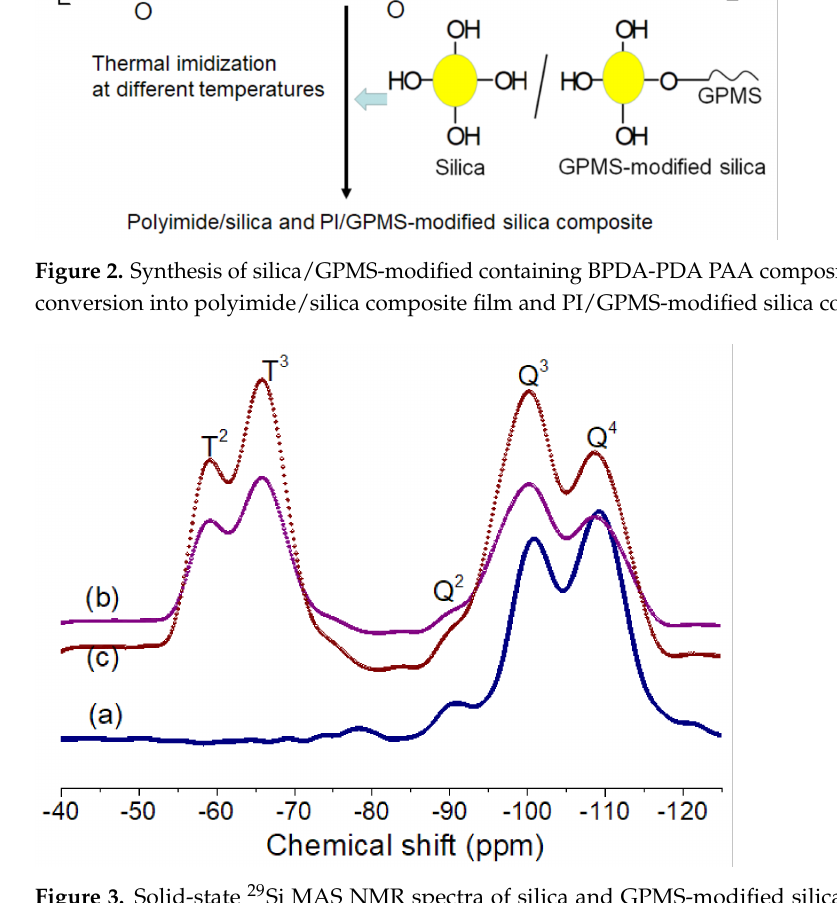
Figure 3. Solid-state 29 Si MAS NMR spectra of silica and GPMS-modified silica samples: ( a ) TSi, ( b ) TSi-GPMS25, and ( c ) TSi-GPMS50.